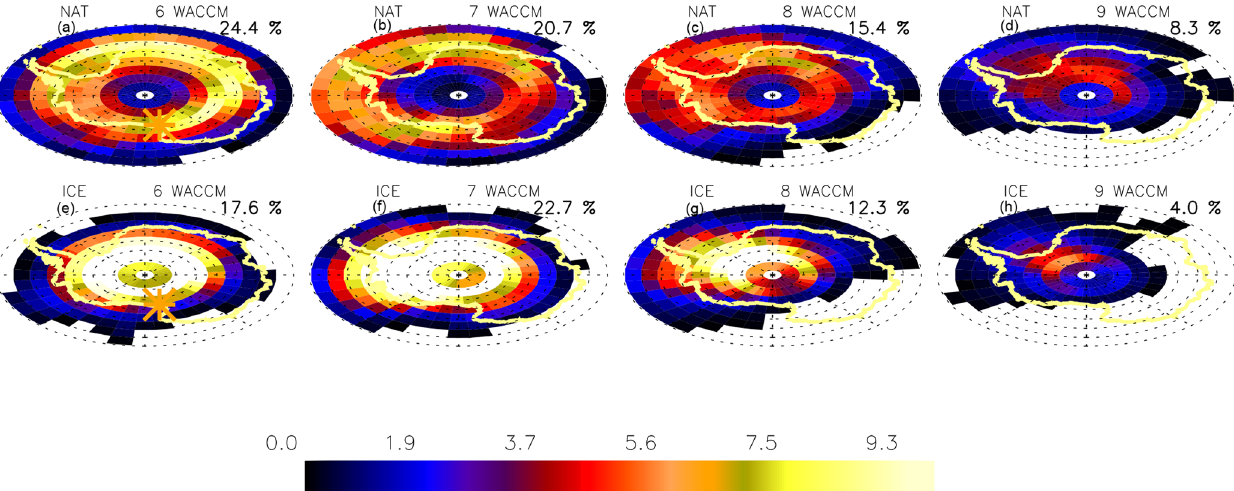
Figure 9. WACCM PSCs vertical extent (in km) for NAT and ice, averaged over 5 years during the months of June, July, August and September (left to right). In the left column, the location of McMurdo is indicated with a yellow asterisk. The fraction of the overall air volume (between 12 and 30km height south of 60 ◦ S) occupied by different PSC classes for each month is reported in the top-right